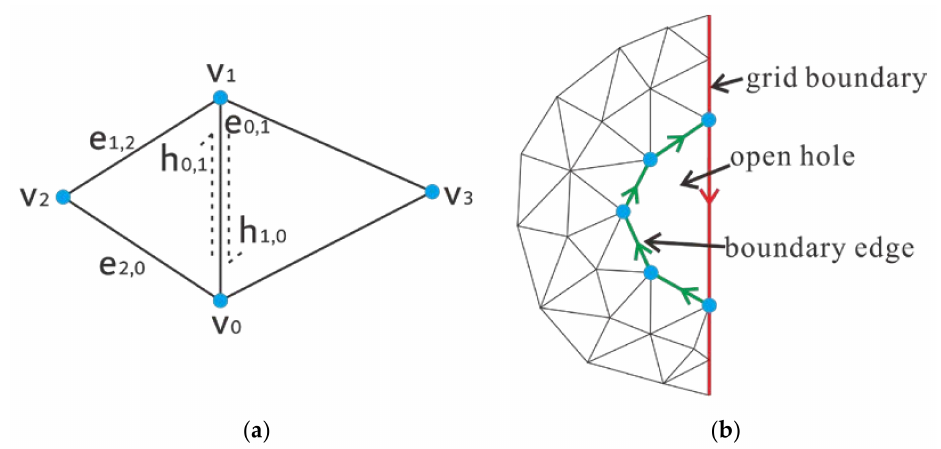
Figure 3. Preliminaries: ( a ) a half-edge data structure; ( b ) a triangular mesh with an open hole. Based on the positions of the open holes in the reconstruction area, the open holes are first classified into two categories: Type I, internal boundary holes, for which the grid boundary contained in the loop is not also a boundary of the reconstruction area, as shown in Figure 4a, and Type II, external boundary holes, for which the grid boundary contained in the loop is a boundary of the reconstruction area, as shown in Figure 4b.